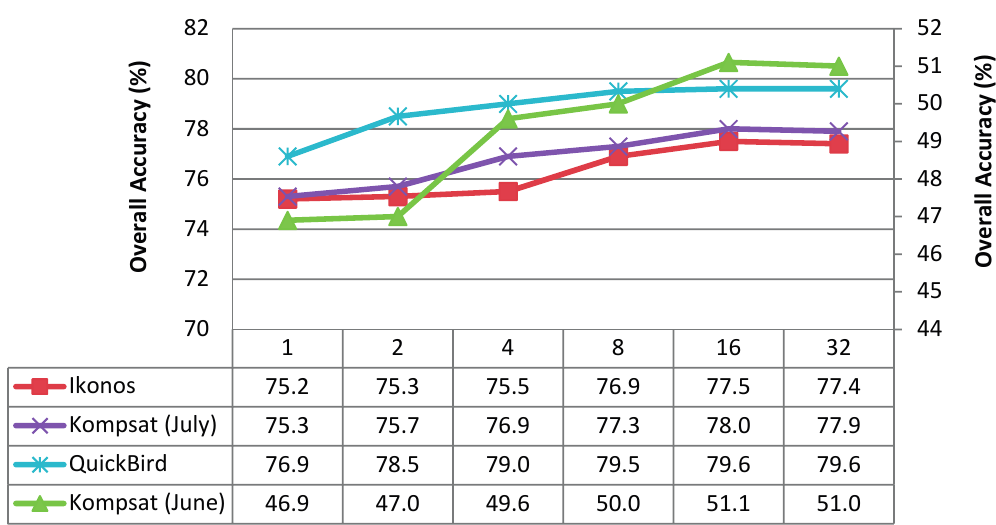
Figure 12. Overall accuracy vs. number of trees of RF classifier. (The results of Kompsat-2 June image are presented on the right y axis to improve